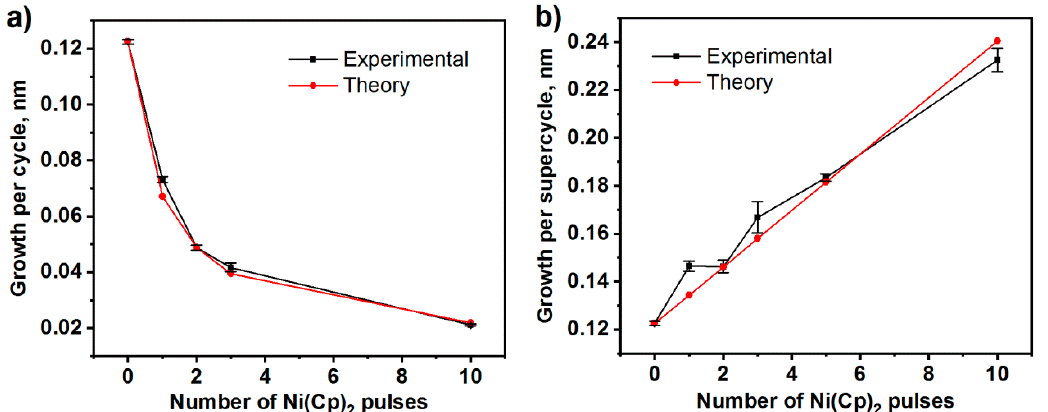
Figure 1. Experimental and calculated growth per cycle as a function of Ni(Cp) 2 pulses ( a ), experimental and calculated growth per supercycle as a function of the Ni(Cp) 2 pulses ( b ).